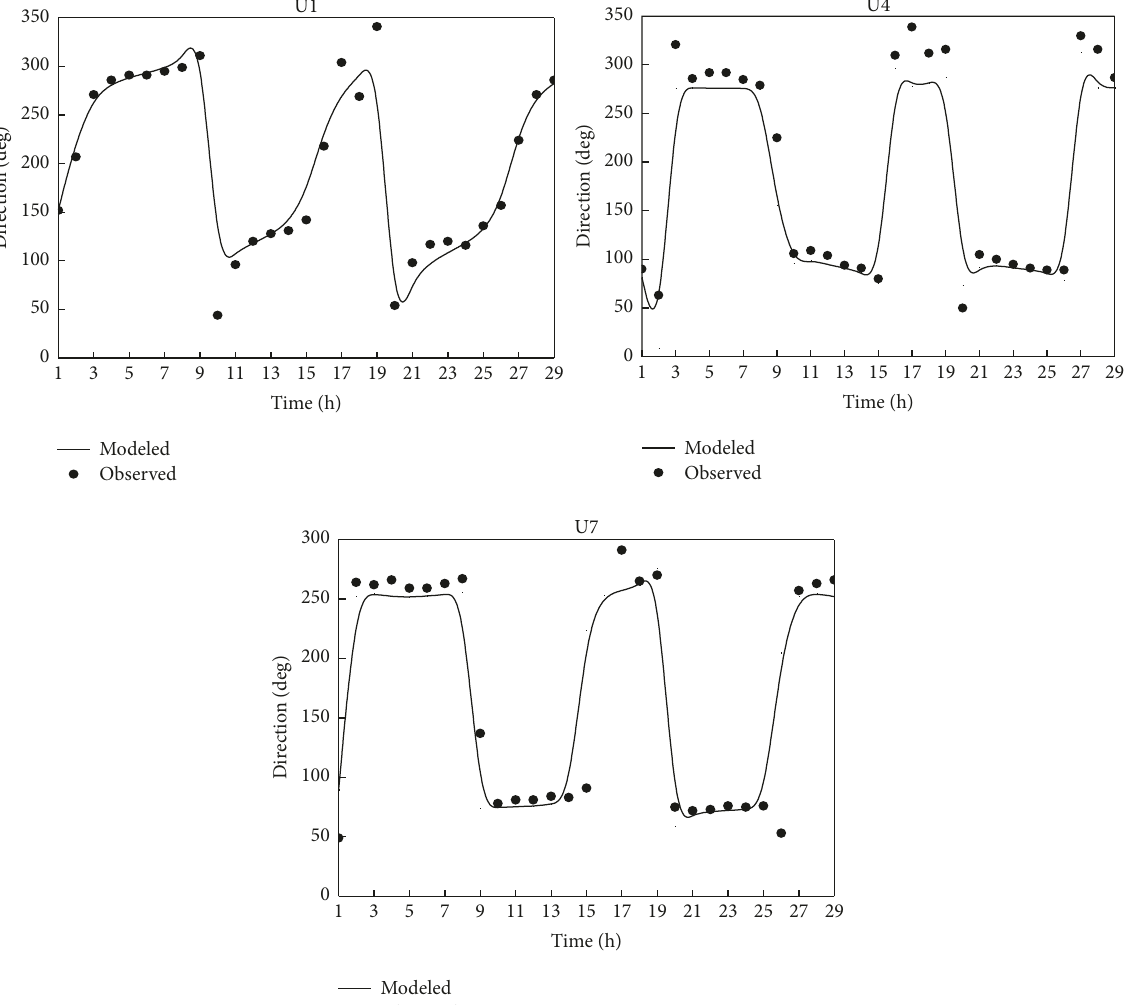
Figure 11: Comparison of flow direction between the modeled (solid line) and the observed (dots) results at three stations (U1, U4, and U7).